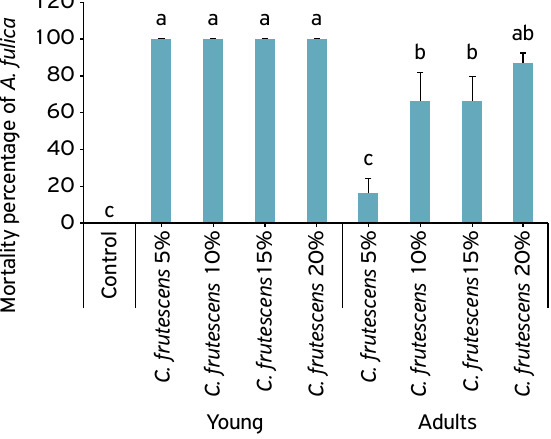
Figure 3. Mortality percentage ( ± standard error) of young and adults of Achatina fulica treated with alcoholic extract of Capsicum frutescens in concentrations of 5, 10, 15 and 20%